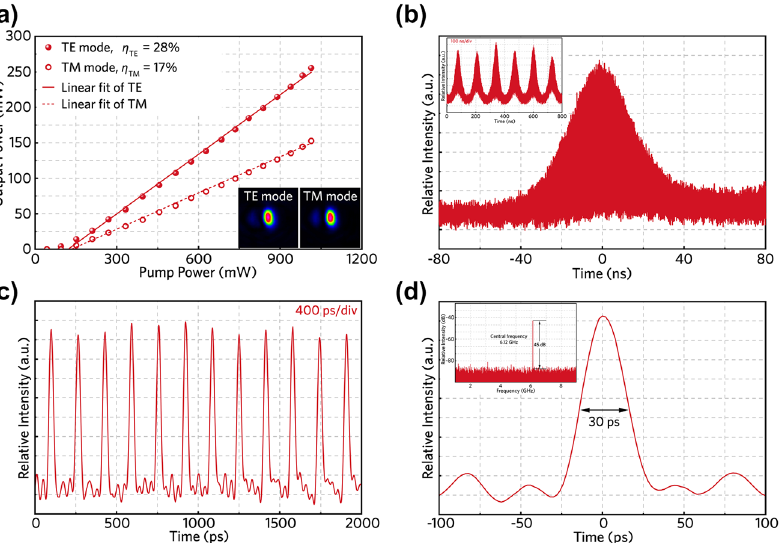
Figure 6: Q -switched mode-locked laser generated by inserting HfSe